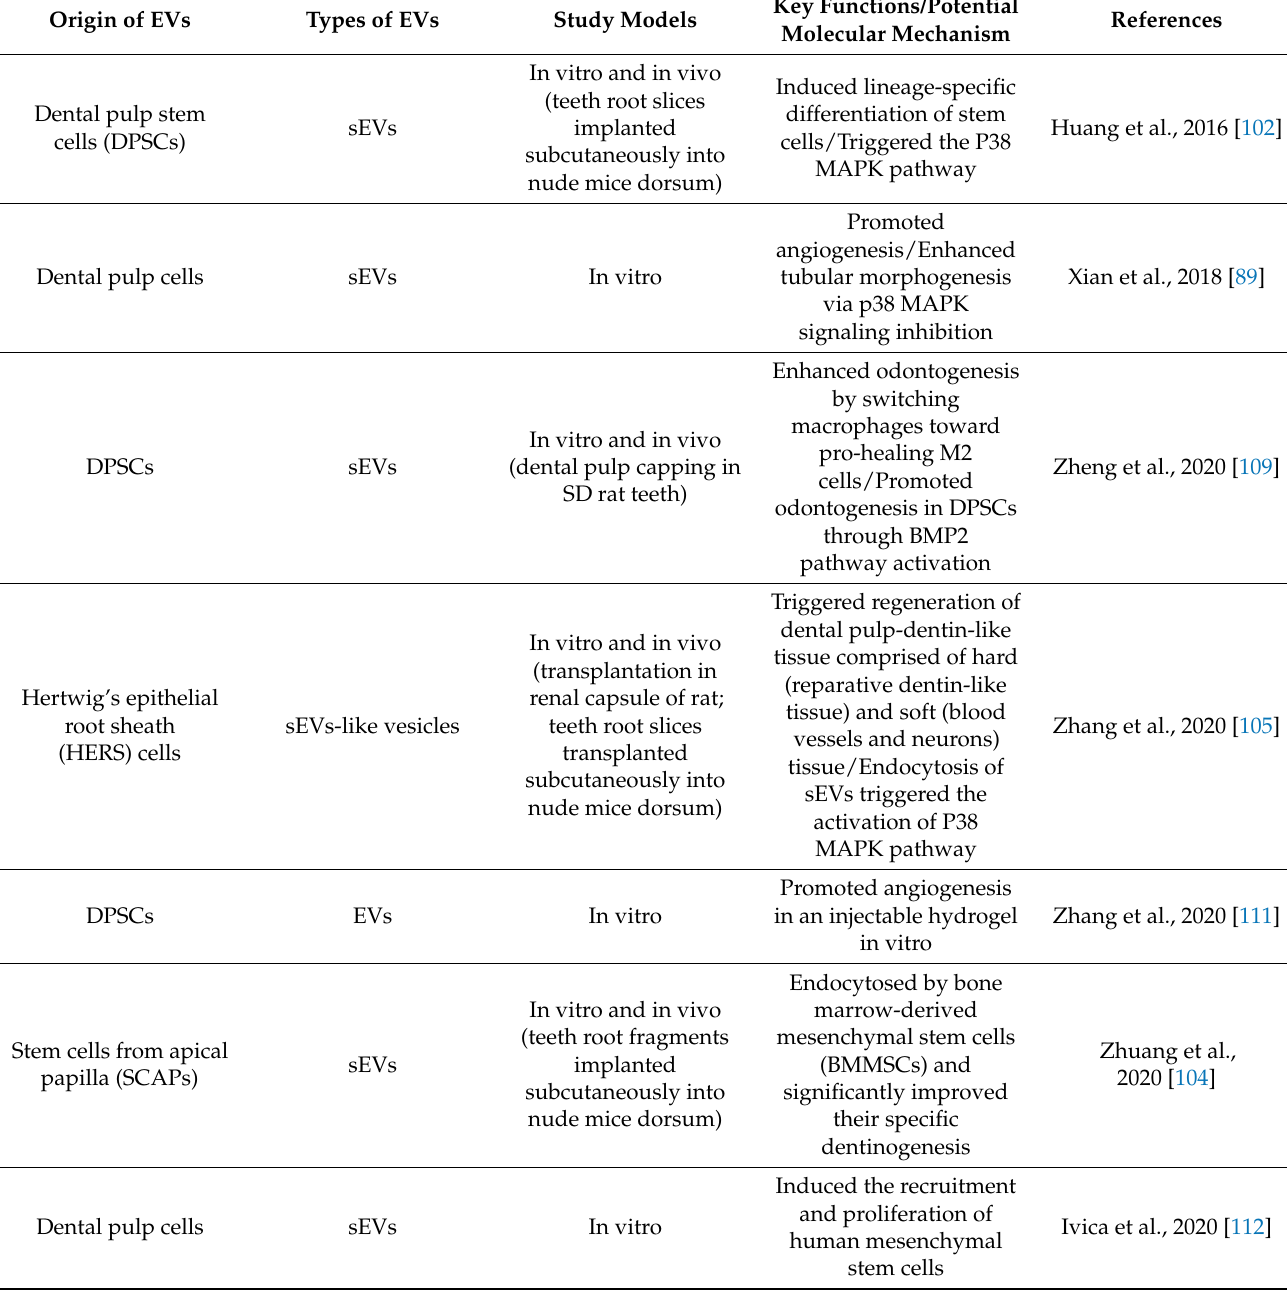
Table 1. Therapeutic effects of EVs in dental pulp